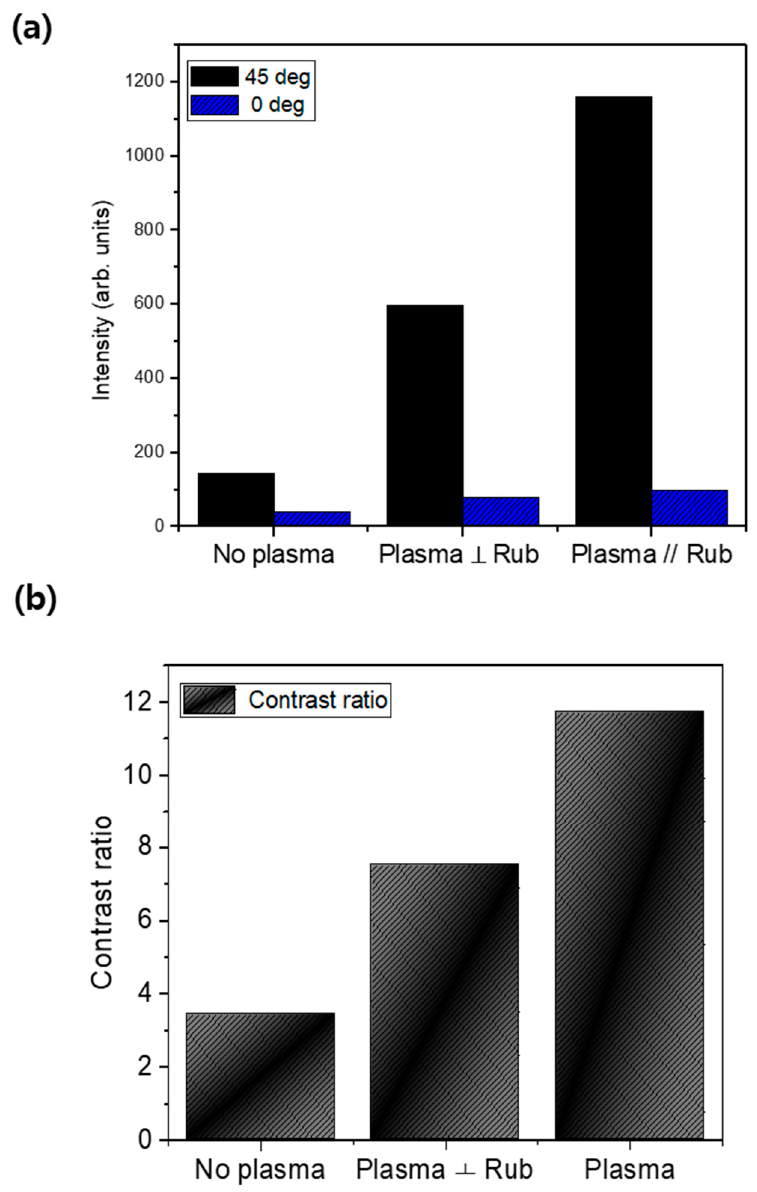
Figure 6. ( a ) Averaged brightness of the POM textures when the rubbing direction of the sample was at 45 ◦ and 0 ◦ to the transmission axis of the polarizer in Figure 5. ( b ) Contrast ratio between bright and dark state obtained from the data in Figure 6a.